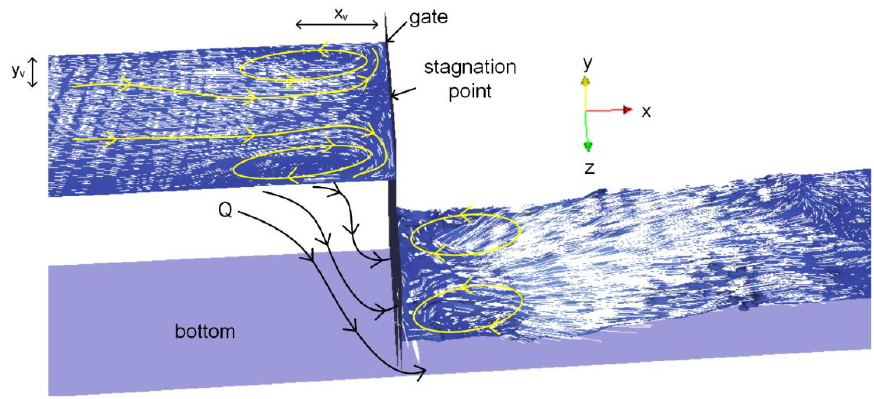
Figure 8. Time-averaged velocity vectors and recirculation zones on the free surface.